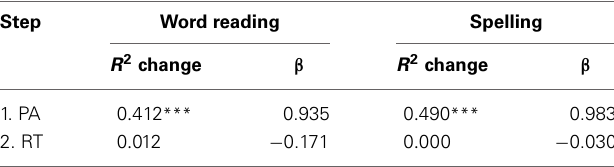
Table 5 | Stepwise regressions showing the unique variance in the word reading, and spelling accounted for by PA and RT ( R 2 change and standardized